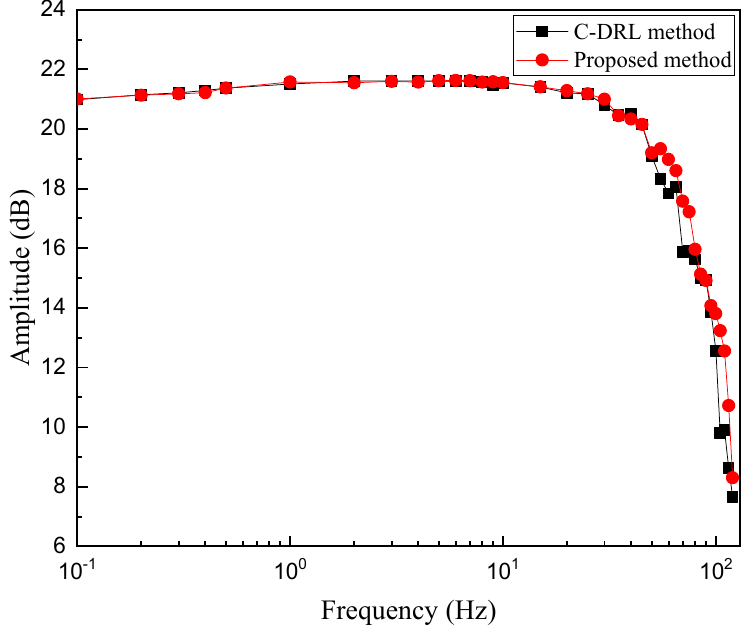
Figure 8. Comparison of the frequency response between the acquisition system with C-DRL method and the acquisition system with proposed method.